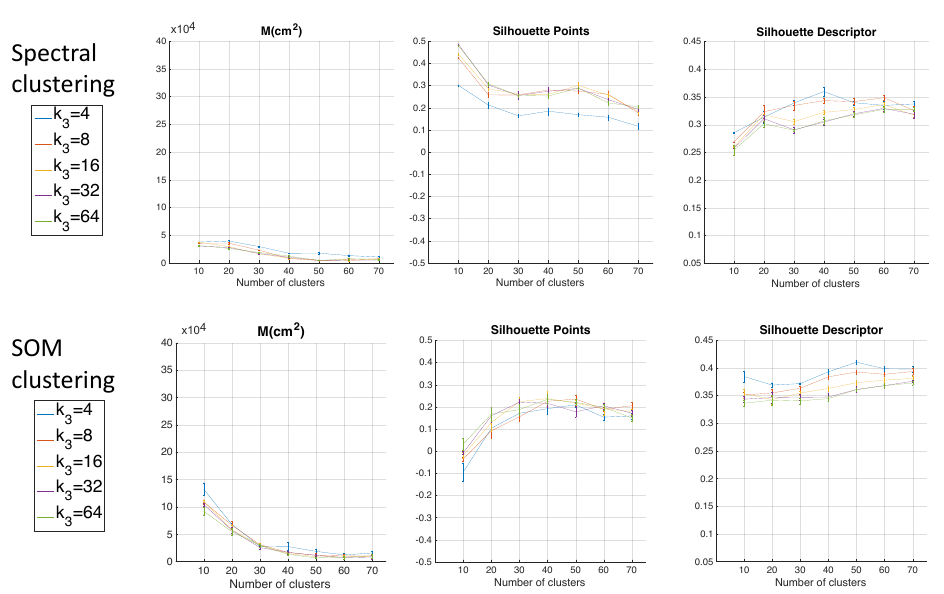
Figure 12. Results of the two clustering methods: average moment of inertia, average silhouette of points, and average silhouette of descriptors vs. number of clusters, when using gist in the Freiburg environment.